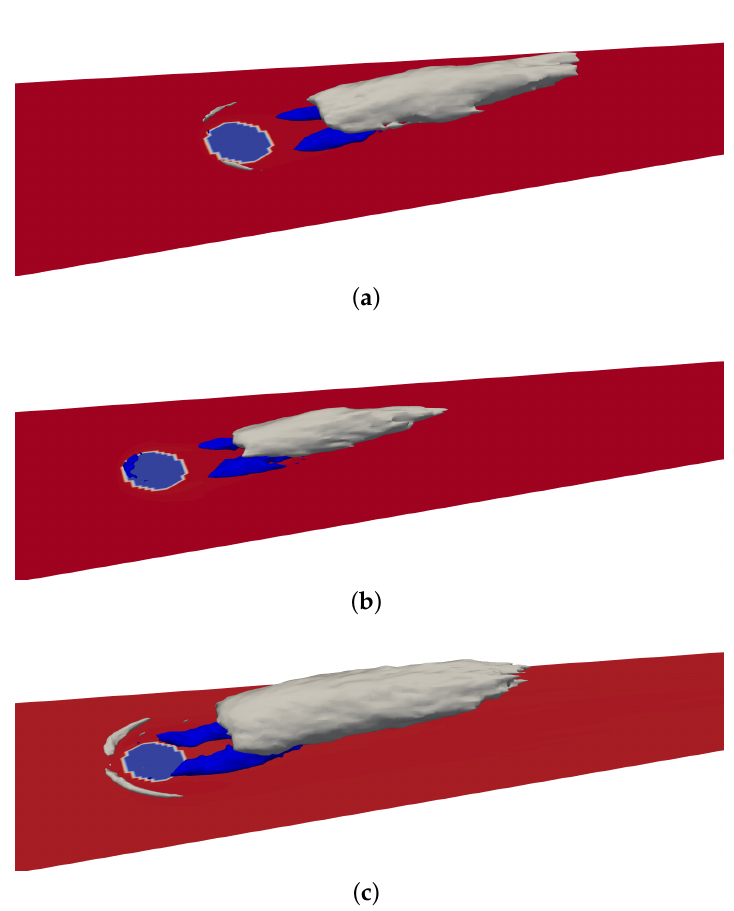
Figure 23. Iso-surfaces of positive (blue) and negative (gray) Reynolds shear stresses < u (cid:48) v (cid:48) > extracted as 25% of the obtained maximum value for VR = 1. ( a ) VR = 0.5 ZPG. ( b ) VR = 0.5 FPG. ( c ) VR = 1